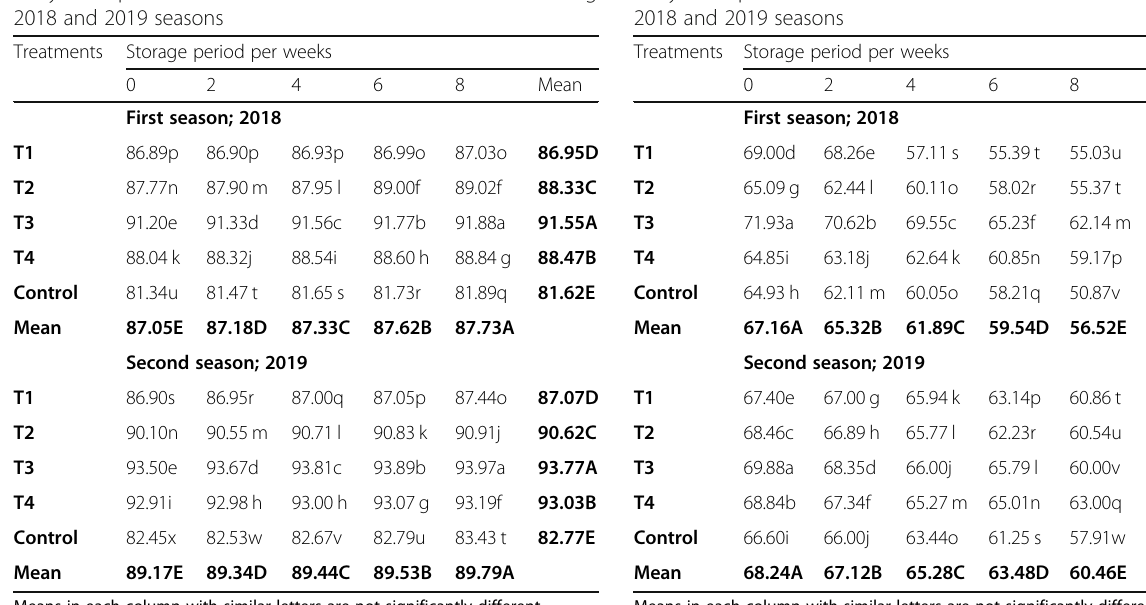
Table 9 Effect of preharvest spraying with moringa leaf extract, boric acid, and chelated calcium on antioxidant activity of Hollywood plum fruits stored at 0 ± 1 °C and RH 85 – 90%